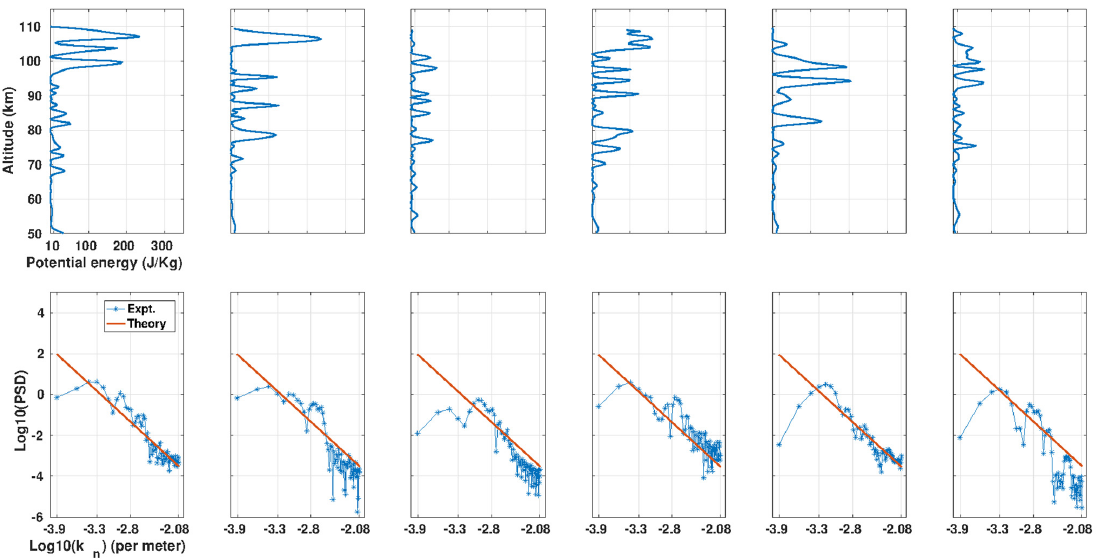
Figure 8. Potential energy of the gravity wave ( top panels ) versus altitude and logarithm of theoretical ( red line ) and experimental ( lines with asterisks ) power spectral density normalized temperature perturbation versus the logarithm of the vertical wave number of atmospheric gravity wave ( bottom panels ) on 16 October 2011.